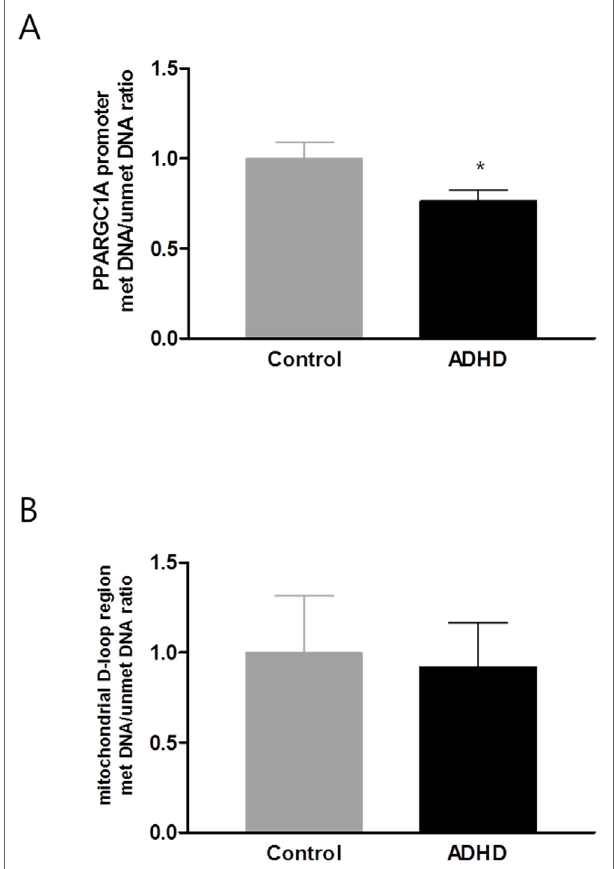
FIGURE 2 | DNA methylation level of PPARGC1A promoter region (A) and D-loop region (B) . PPARGC1A , peroxisome-proliferator-activated receptor γ co-activator-1 α ; ADHD, attention-deficit hyperactivity disorder. * p <